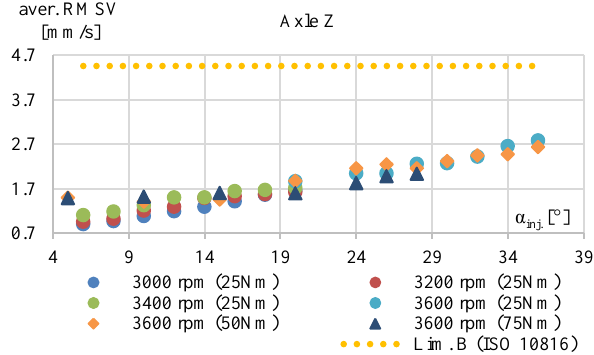
Fig. 16. Average RMS value of the vibration velocity depending on the injection angle for the Z axis (25, 50 and 75 Nm)